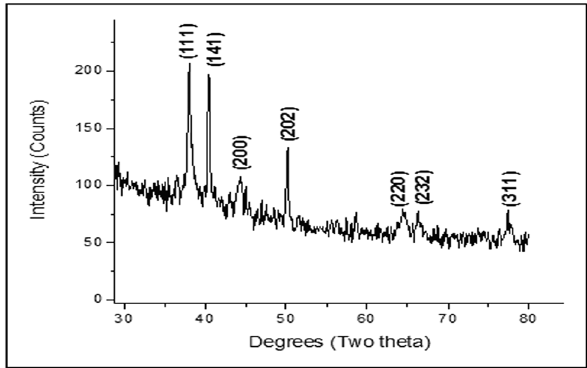
Figure 5: XRD patterns of V. jatamansi shoot